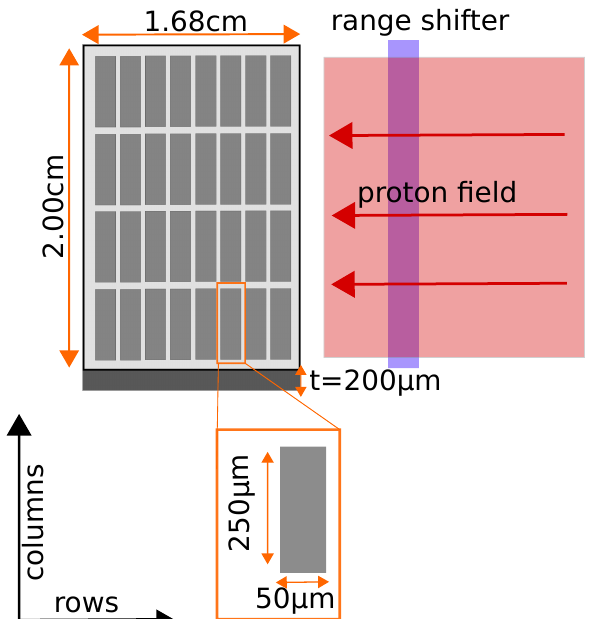
Figure 5. Sketch illustrating the direction of the proton pathway through the sensor aligned parallel with the beam